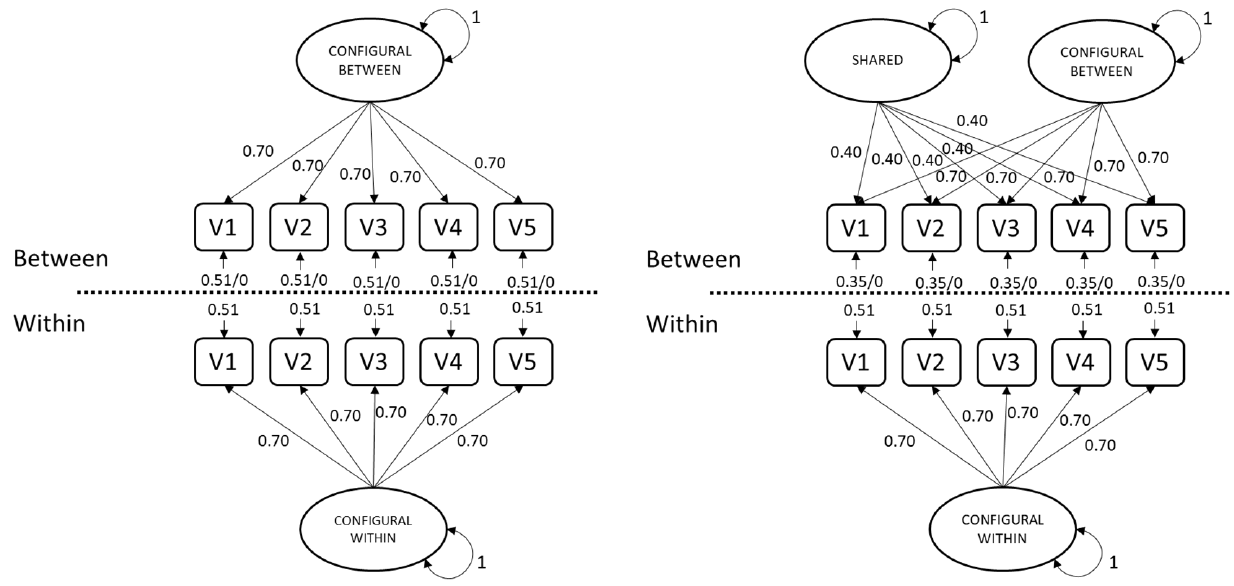
Figure 1. Data generating models with parameter values.